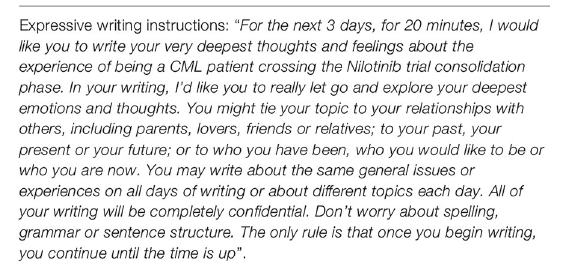
FIGURE 2 | Writing instructions for diaries compilation at month 18 and at month